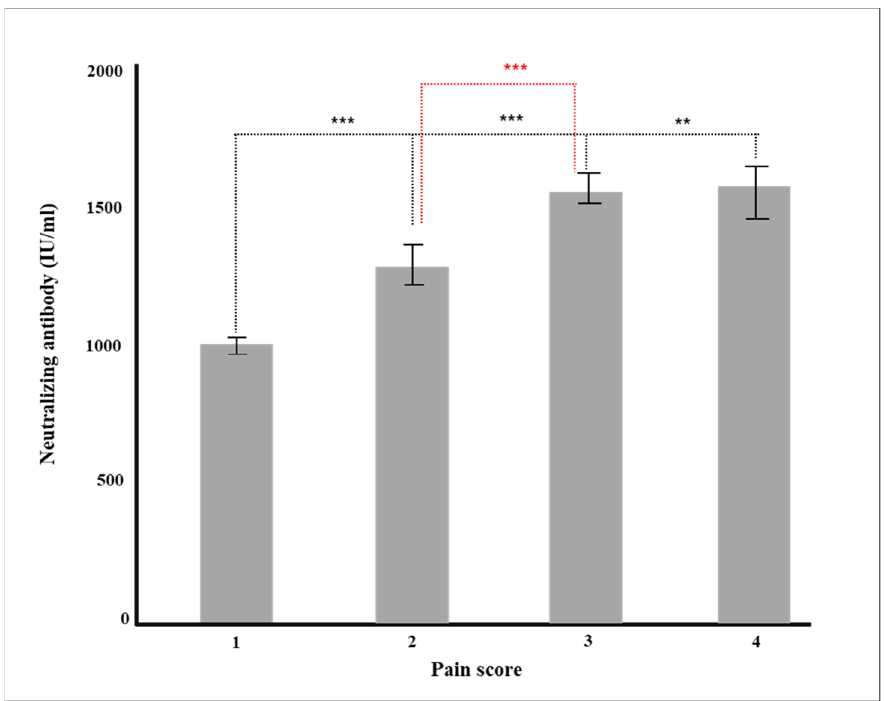
Figure 4. Production of neutralizing antibody according to pain after vaccination (** p < 0.01, *** p < 0.001).